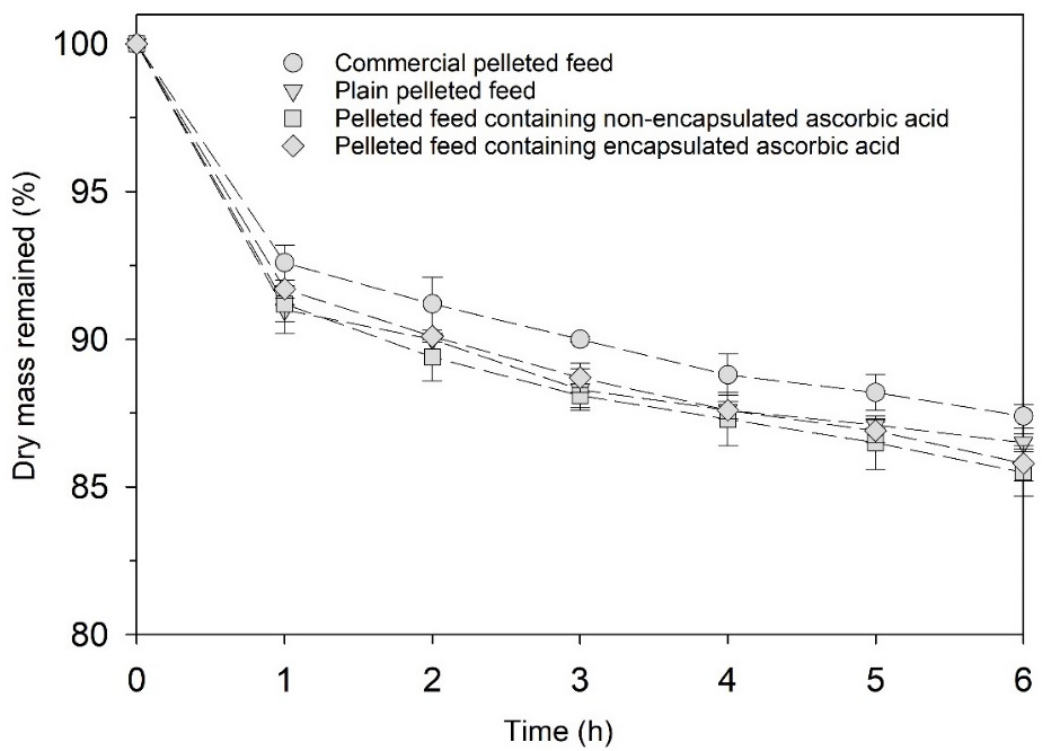
Figure 5. Stability of the pelleted shrimp feeds in seawater (plain pelleted feed, pelleted feed containing unencapsulated AA and pelleted feed containing microencapsulated AA). The stability was reported in terms of the mass ratio of the pelleted feed remained after exposure to seawater to its initial mass. Table 3. Retention of AA in pelleted feed at each step of feed processing and during 6-h of the exposure to